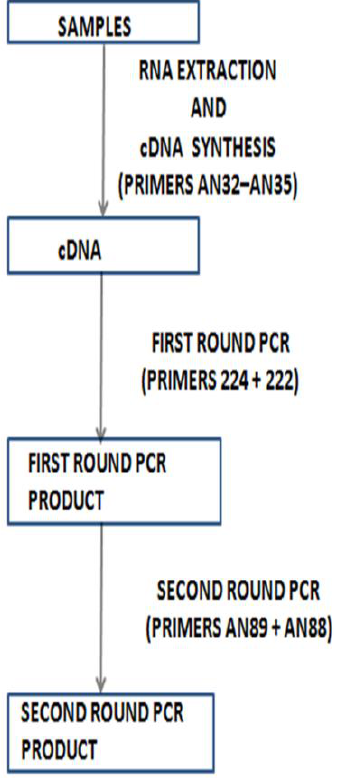
Figure 2. Recently recommended algorithm for direct detection of enteroviruses from clinical specimens (WHO, 2015).